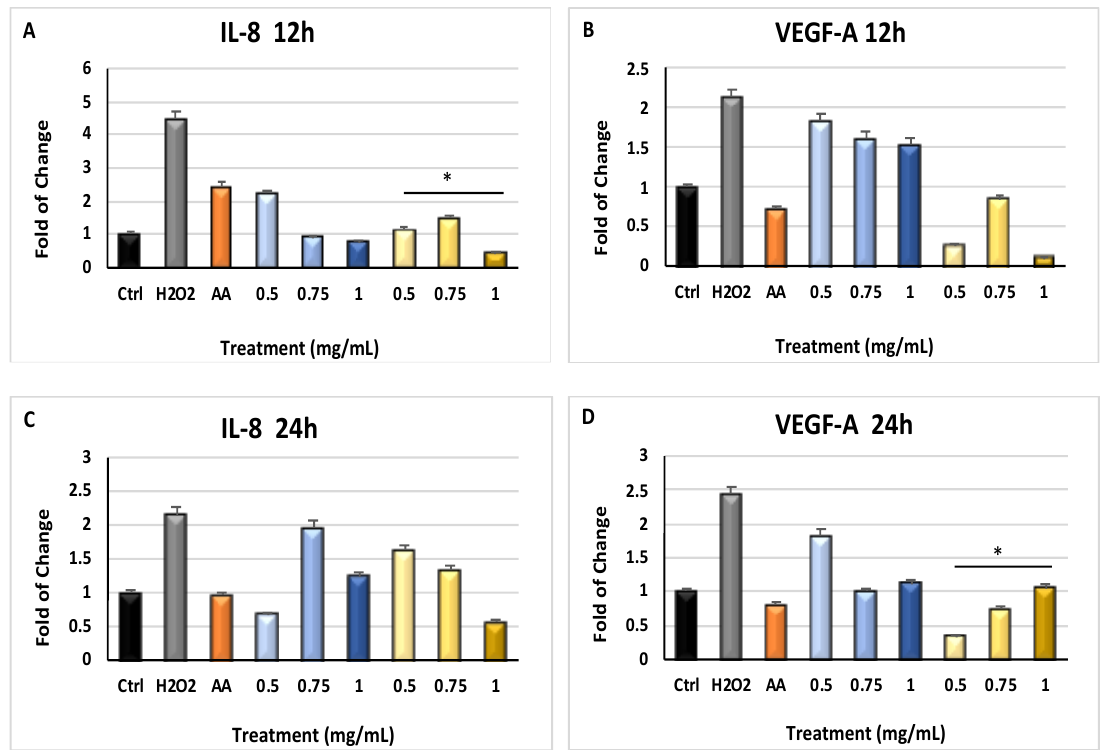
Figure 3. Gene expression of the proinflammatory cytokines Il-8 and VEGF-A. The expression of Interleukin 8 (IL-8) and Vascular endothelial growth factor A (VEGF-A) was evaluated at 12 h and 24 h (Panels ( A ) and ( B ), and panels ( C ) and ( D ), respectively). HFF1 were exposed to ascorbic acid (AA, orange bar), or to 0.5, 0.75 and 1 mg / ml seeds waste extracts (blue bars) or 0.5, 0.75 and 1 mg / mL pulp waste extracts (yellows bar). H 2 O 2 (grey bar) represents HFF1 cells exposed to only H 2 O 2, without previous extracts treatment. The mRNA levels for each gene was expressed as fold of change (2 − ∆∆ Ct ) of mRNA levels observed in untreated HFF1 (CTRL, black bar) defined as 1 (mean ± SD; n = 6) and normalized to Glyceraldehyde-3-Phosphate-Dehidrogenase (GAPDH). Data are represented as mean ± SD referred to the control (* p ≤ 0.05, ** p ≤ 0.01 and *** p ≤ 0.001).